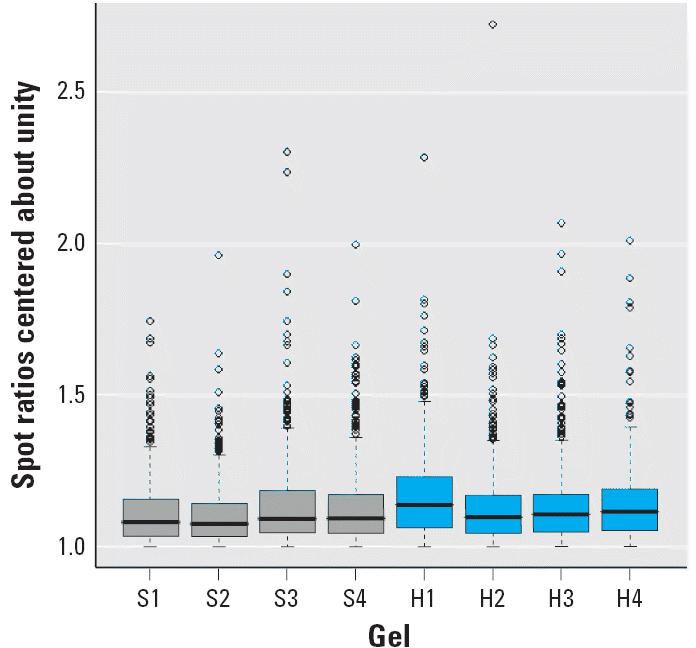
Box plots of the spot ratios from the four gels from the (S) striatum and the (H) hippocampus. The box limits are the first and third quartile, closely representing 50% of the data. The whiskers extend to the most extreme data point, which is no more than 1.5 times the length of the box away from the box. The overall average and SD of the log2 95% ratios averages 0.141 ± 0.016 for the striatum and 0.165 ± 0.022 for the hippocampus, corresponding to log2 95% prediction limits of 0.199 and 0.242, respectively. S1–S4, gels 1–4 (see Figure 1) for striatum; H1–H4, gels 1–4 for hippocampus.